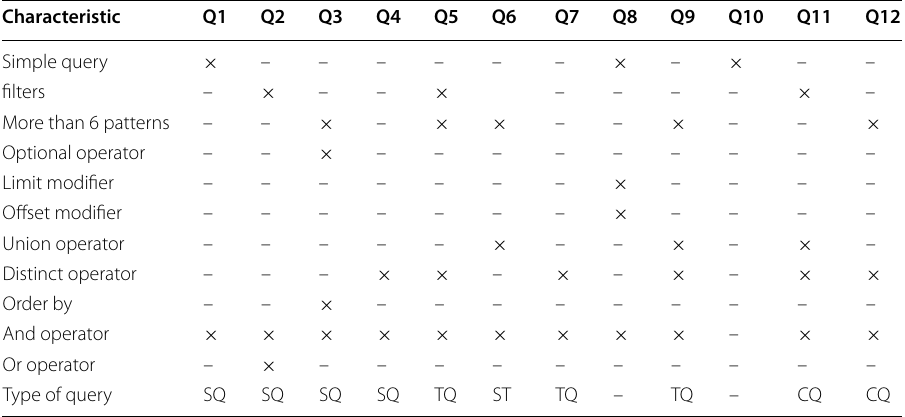
Table 4 Characteristics of tested queries Characteristic